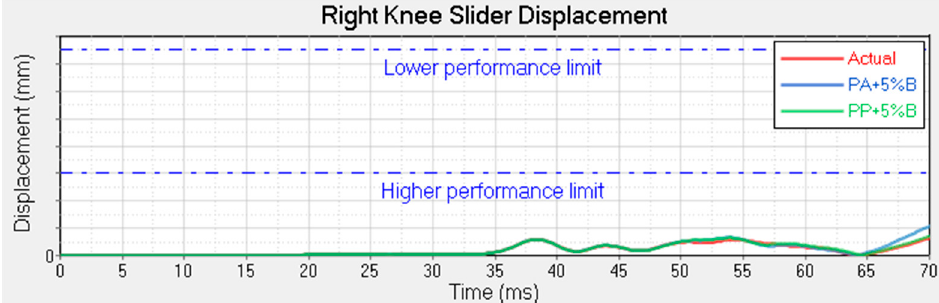
Figure 11. Right knee slider displacement.